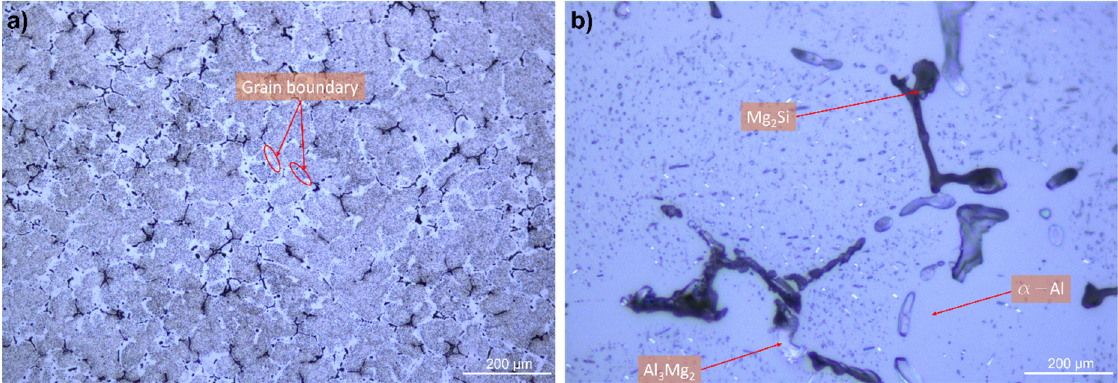
Figure 2. Optical microscopy images of mirror-liked polished samples AlMg3: ( a ) 200 µm and ( b ) 20 µm.